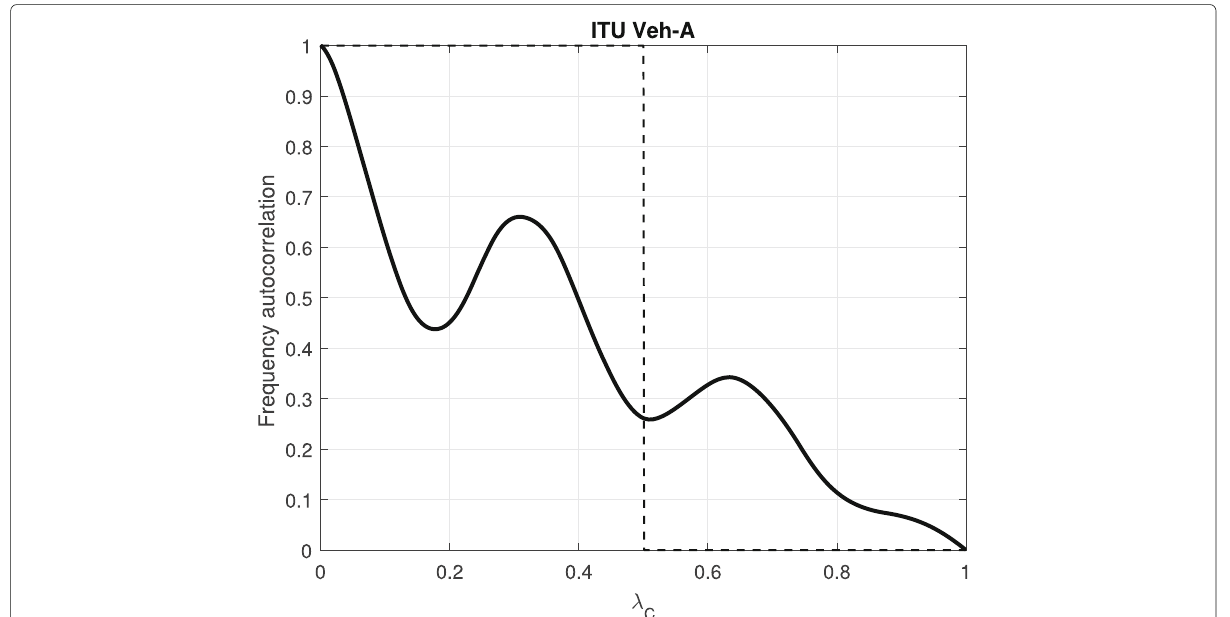
Fig. 9 Frequency autocorrelation of ITU-VehA channel model. Frequency autocorrelation of ITU-VehA channel model (continuous line) vs. the parameter λ C , here defined as (cid:9) f / B . The ideal autocorrelation of the frequency selective model for λ C = 0.5 (dotted line) is reported for comparison